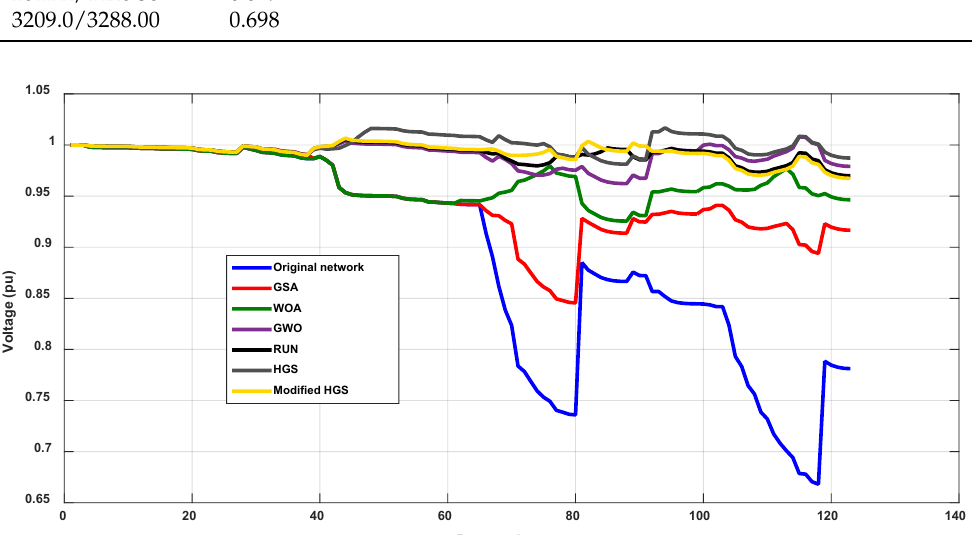
Figure 11. IEEE 119-bus network voltage profiles with and without BDGs.